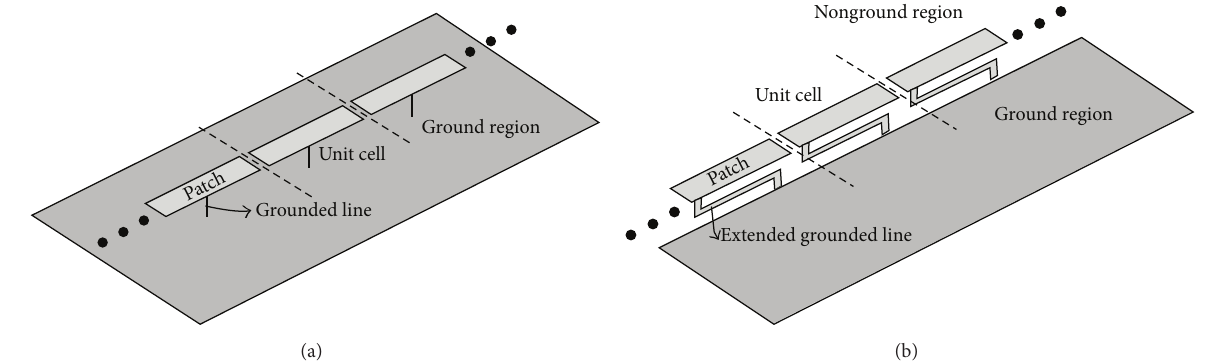
Figure 2: Structure for a DNG transmission line. (a) Conventional mushroom. (b) Modified mushroom.